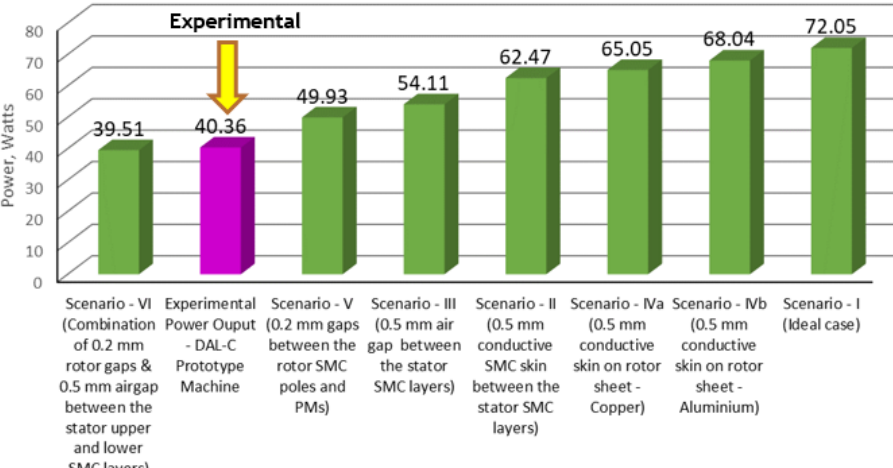
Figure 21. Comparison between different manufacturing scenarios and experimental power.